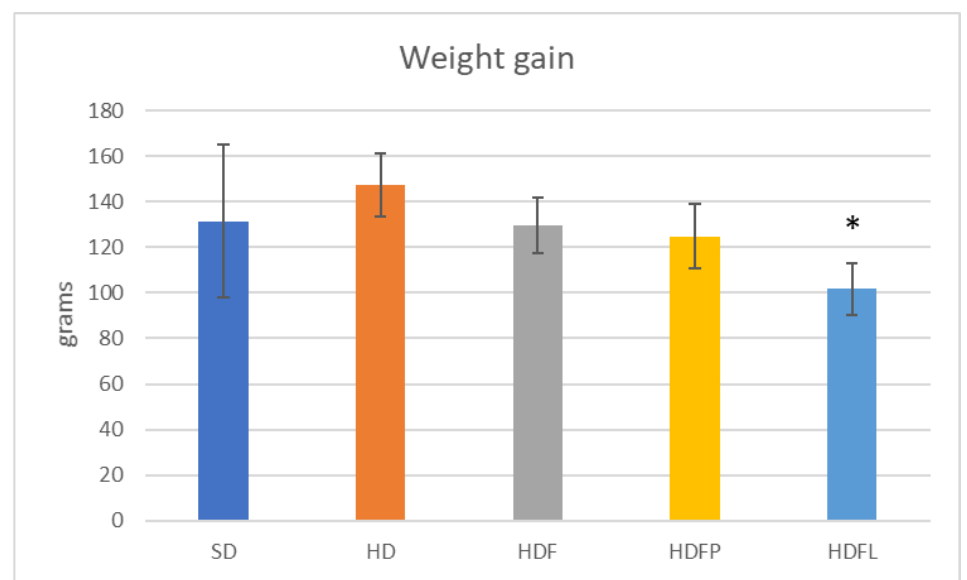
Figure 6. Weight gain after eight weeks of treatment. Asterisks denote a significant difference vs. HD group ( p < 0.05) after one-way ANOVA and Tukey tests. Error bars are ± standard deviation. Treatment acronyms as in Figure 4. * p < 0.05.